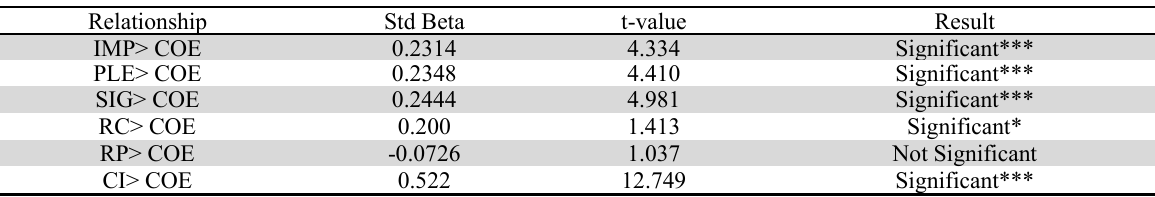
Path Coefficient Relationship Std